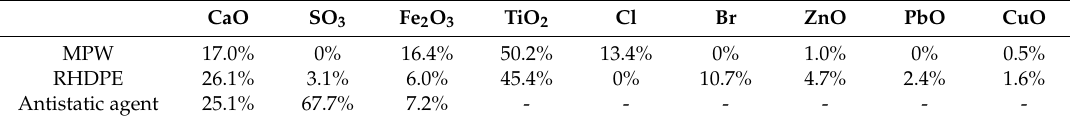
Table 4. XRF results of raw plastic materials and antistatic agent.